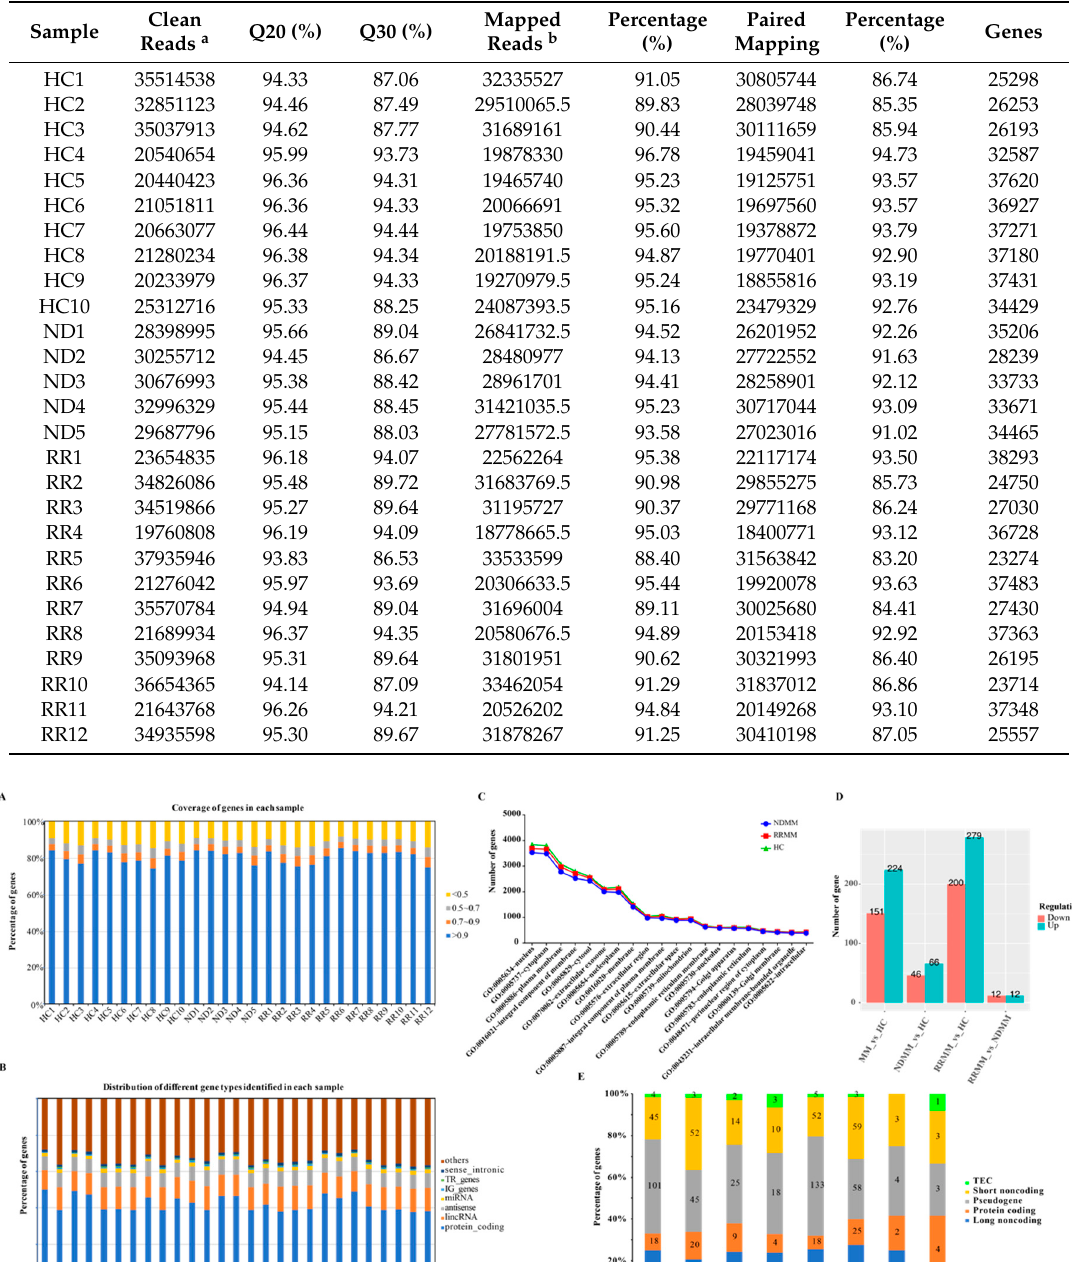
Table 2. Overview of the extracellular RNA (exRNA) transcriptome sequencing. Q20 and Q30 were applied to the clean reads. The number of mapped reads was given by Hisat2 and ‘.5’ means that one of the paired reads was mapped. Percentages were calculated for mapped reads and paired reads matched to the genome. The numbers of genes identified in the samples ( > 5 transcripts per million reads (TPM)) were listed.